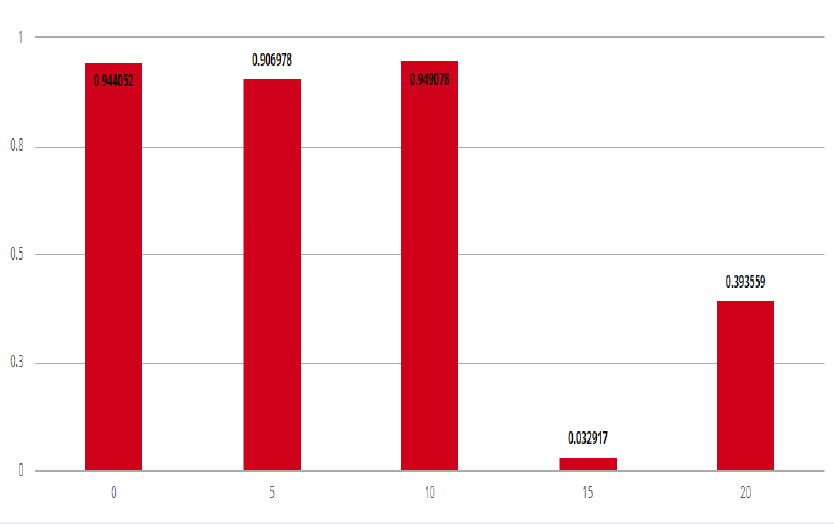
Figure 4 . Closeness coefficient graph using fuzzy